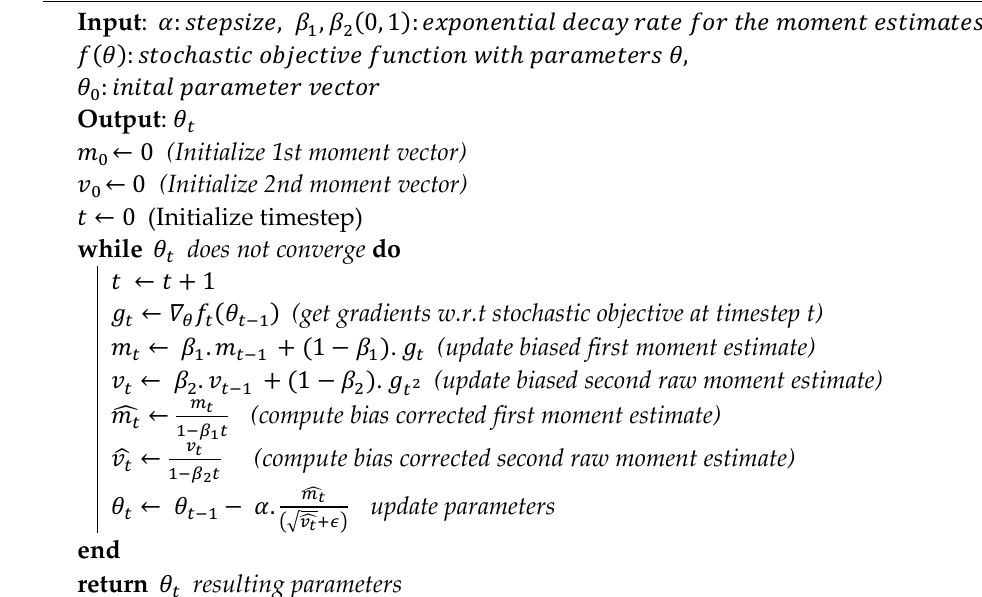
Algorithm 1: Pseudocode: For the Adam